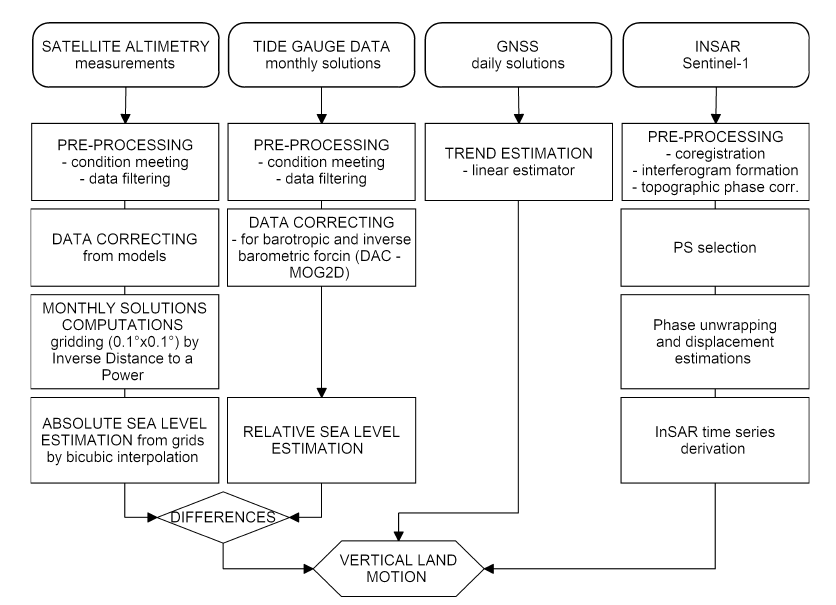
Figure 3. An integrated approach on accessing the vertical land motion (VLM) in the Dubrovnik area based on different input